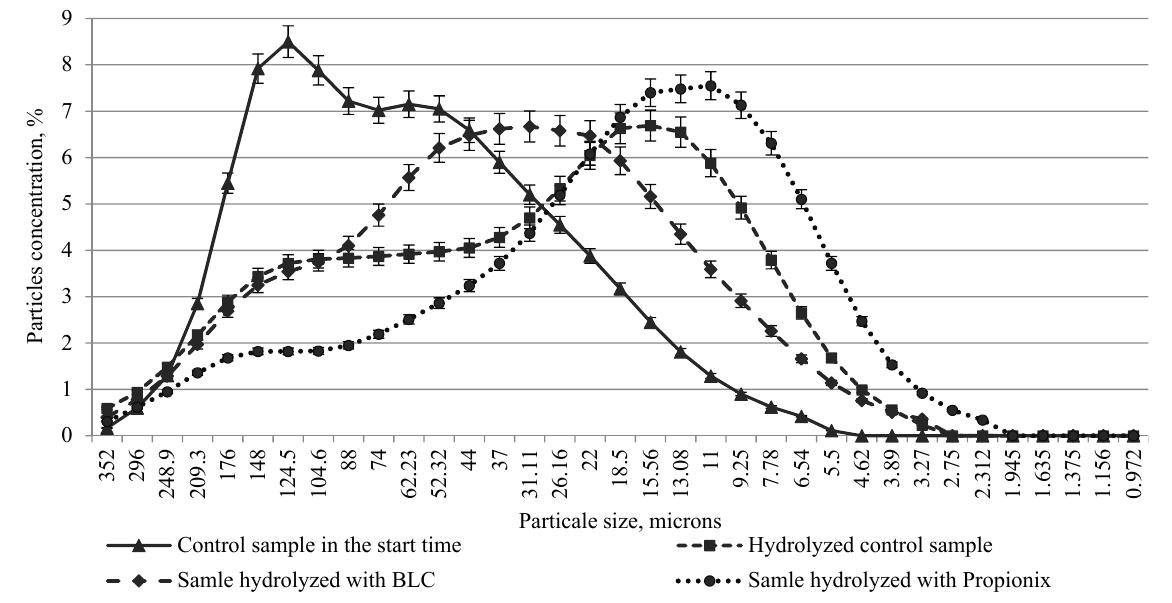
Figure 5. Particle size distribution in the samples of hen gizzard hydrolysates.